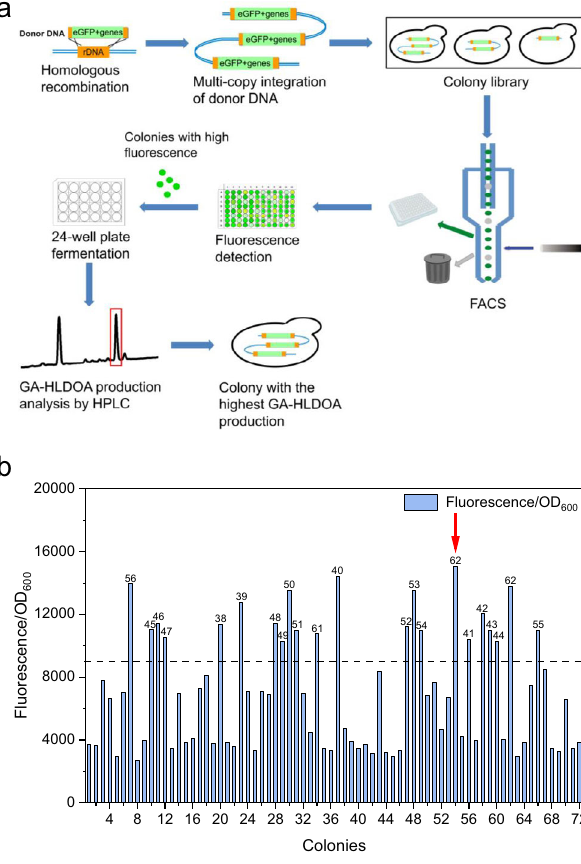
Fig. 5 | Integration of the CYP5150L8 and iGLCPR expression cassettes into yeast rDNA loci promotes the production of 3 and 4. a Schematic illustration of screening of the GA-HLDOA-producing strain. Expression cassettes of eGFP, TRP1, CYP5150L8, and iGLCPR fl anked by 0.55 – 0.70kb homologous recombination regions were used as donors for integration at the rDNA loci. Recombinant clones with high green fl uorescence signal intensity were isolated and selected for fer- mentationtests. b The fl uorescencesignalofpartialclones.The fl uorescencesignal isshownasspeci fi cunitsperOD 600 .Thedottedlineindicatesthatthe fl uorescence signal is 9000. Clones with fl uorescence signals greater than 9,000 were selected